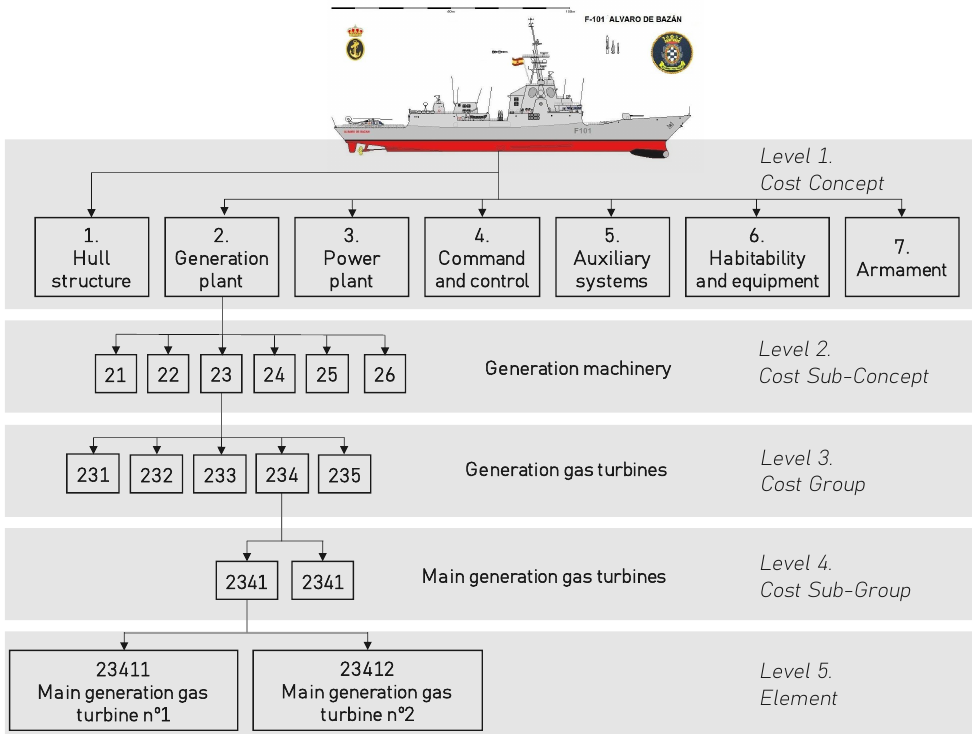
Figure 1. Example of the development of the functional structure